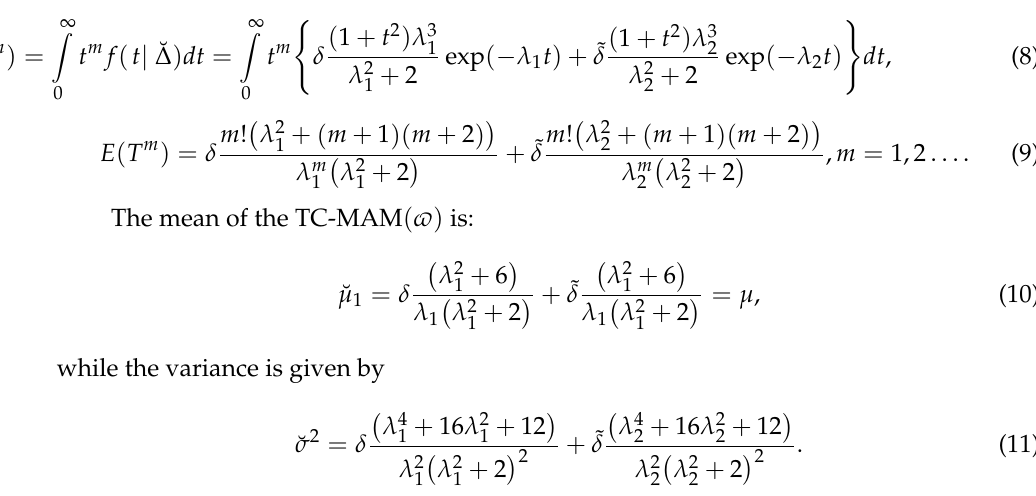
(cid:21) ( t ) ((cid:133)rst component CDF) ; F 1 1 j $ ) ) with (cid:14) against t . ( t m j